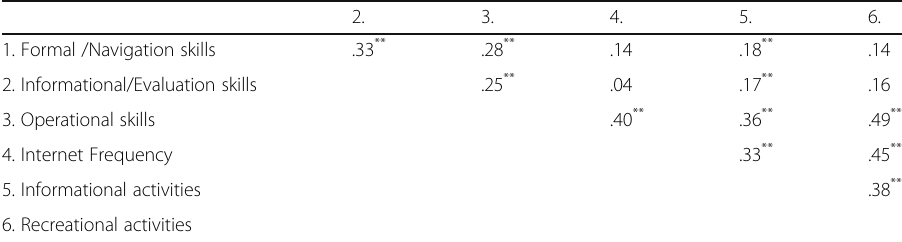
Table 3 Correlations between Internet skills, internet frequency, and online informational and recreational